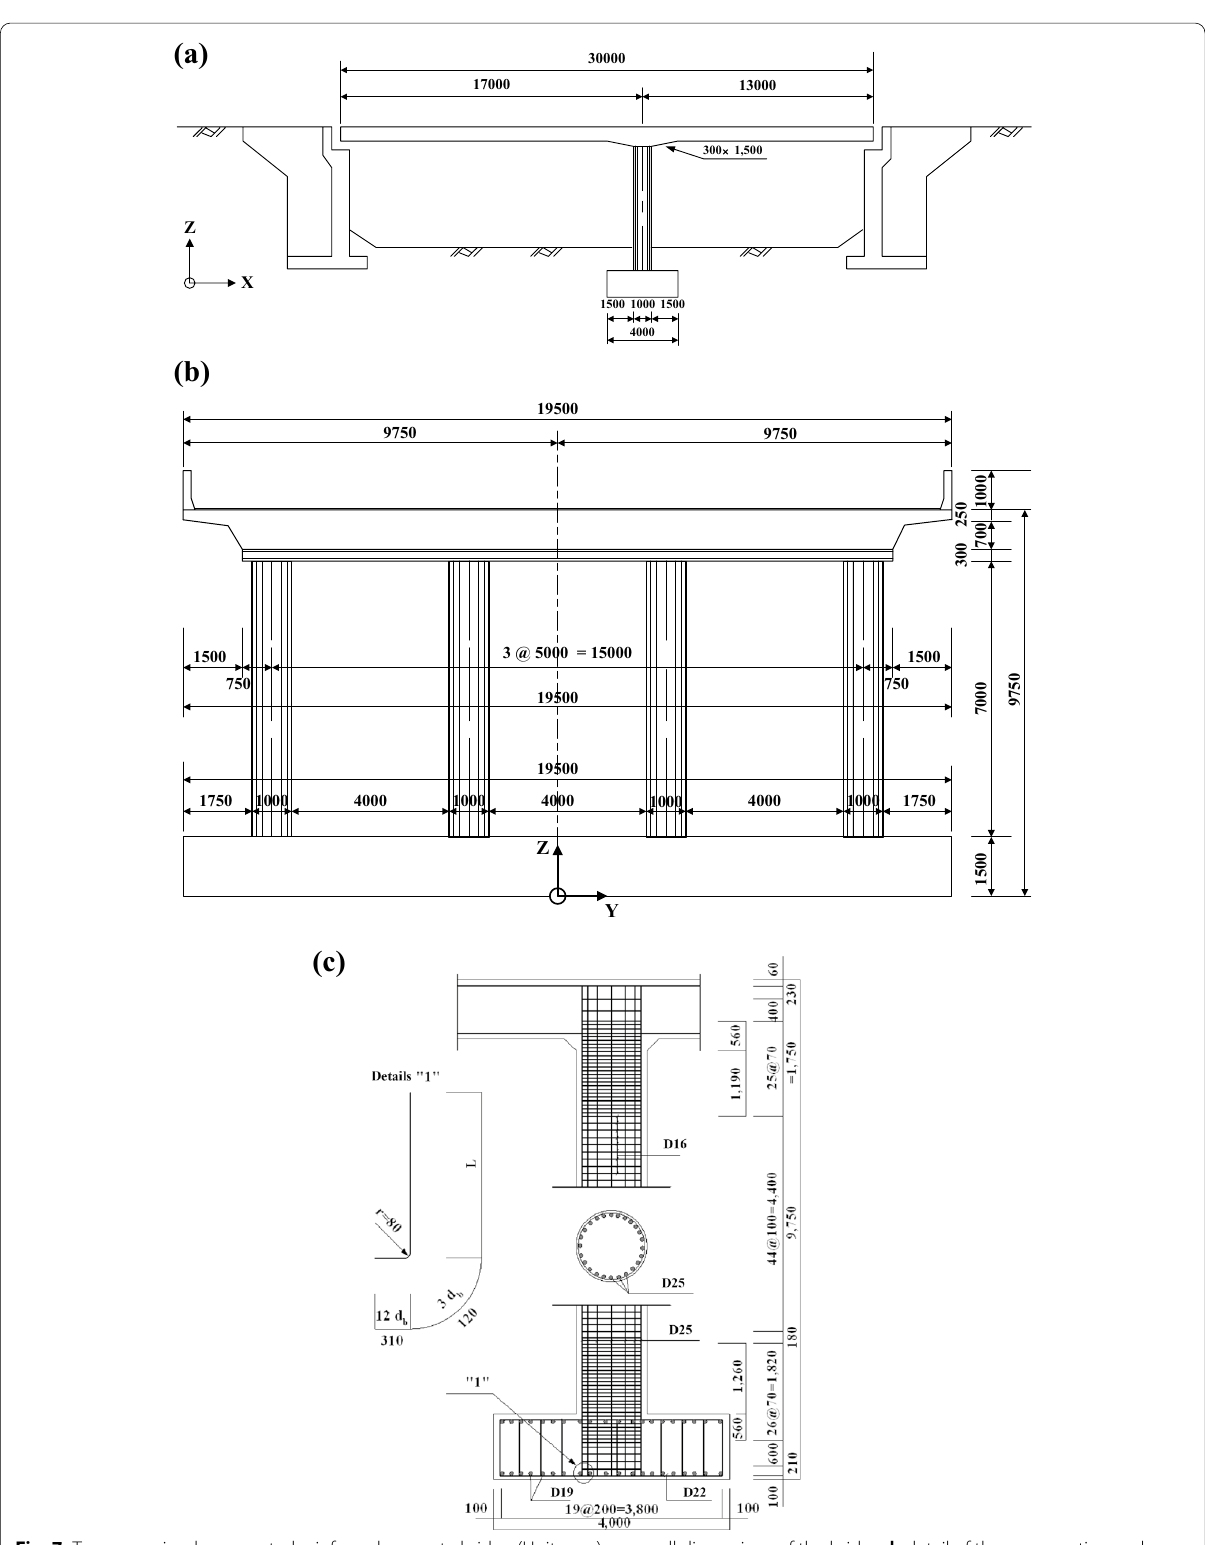
Fig. 7 Two‑span simply supported reinforced concrete bridge (Unit: mm): a overall dimensions of the bridge, b detail of the cross‑section and c details of the reinforcement layout of the